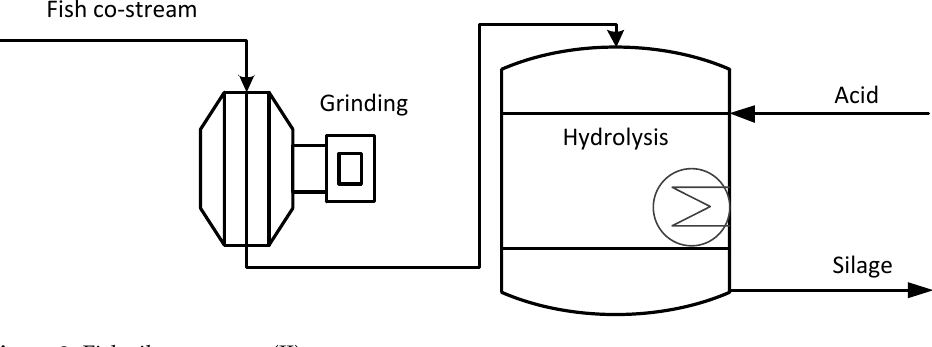
Figure 3. Fish silage process (II).